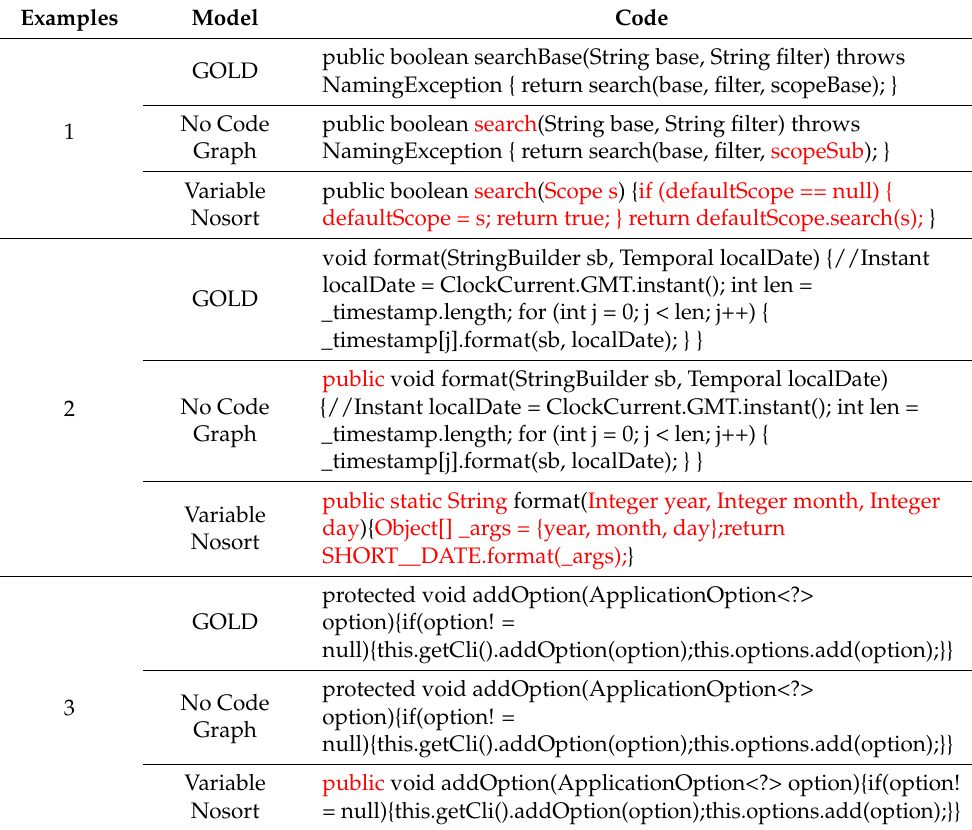
Table 8. Comparison of examples of code generation with and without code